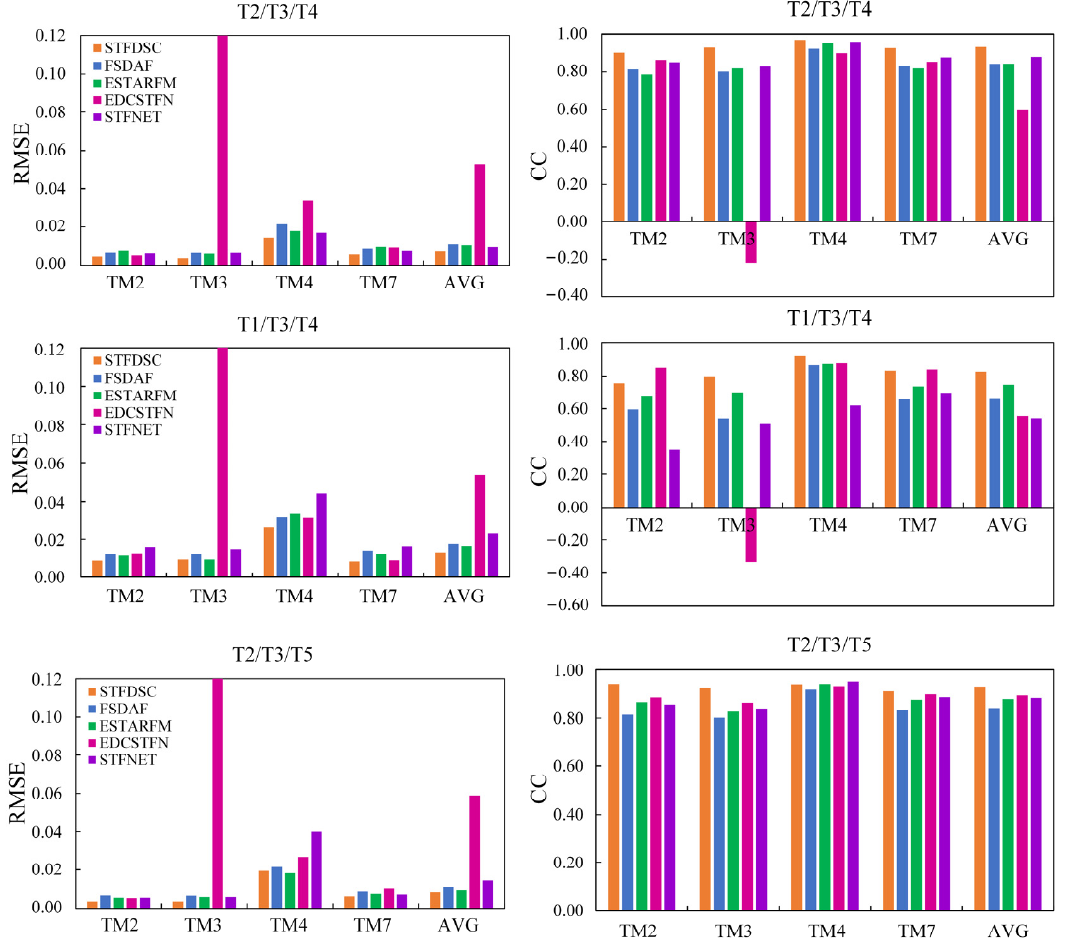
Figure 4. Performance of five STF methods in reconstructing Landsat surface reflectance in the GKM.